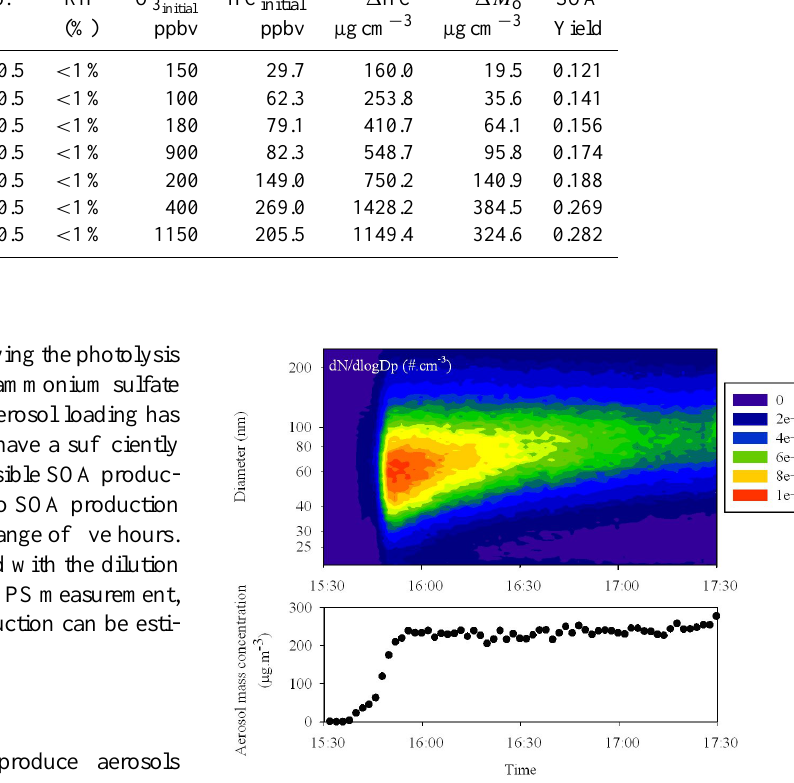
Table 7. Initial conditions and results summary for the set of experiments α -pinene+O 3 . Experiment Temp.